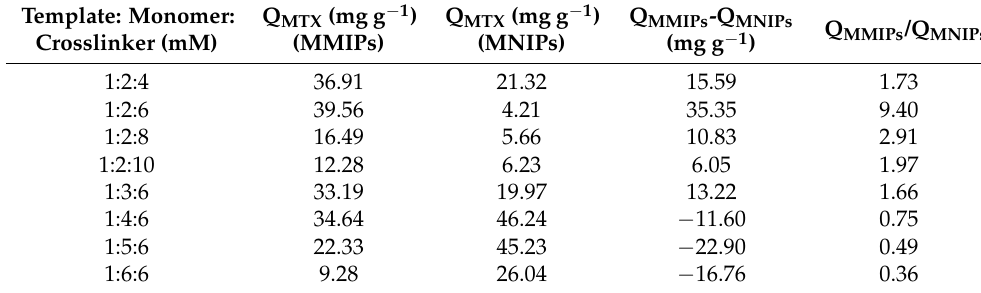
Table 2. The influence of the ratio of the template, monomer, and crosslinker on the adsorption capacity of the